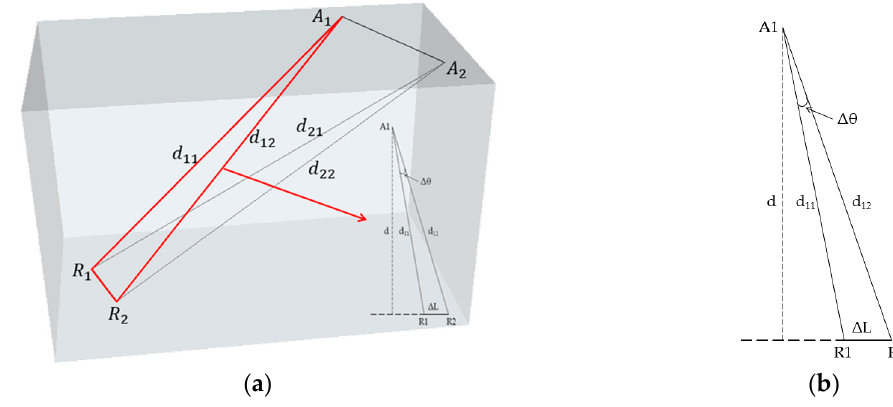
Figure 3. ( a ) AP deployment in Case 2 in three-dimension model; and ( b ) two-dimensional model extracted from three-dimensional model for analysis.